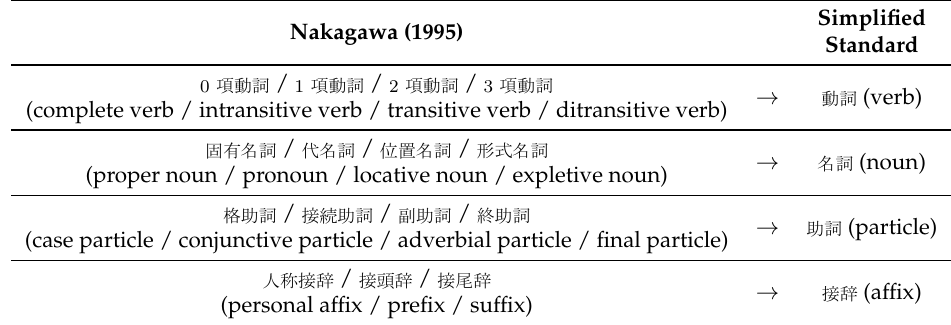
Table 10. POS conversion table, simplified standard.